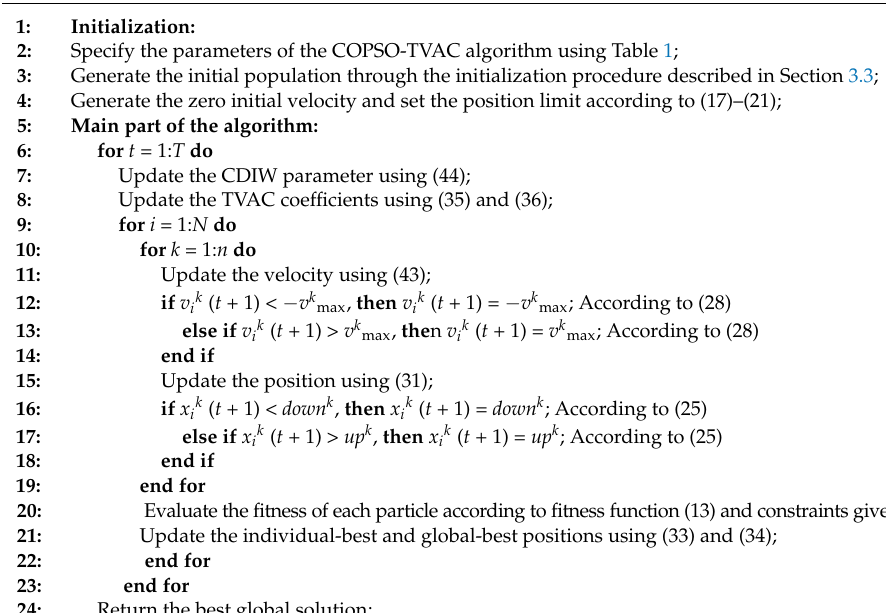
Algorithm 3 COPSO-TVAC algorithm for optimization problem